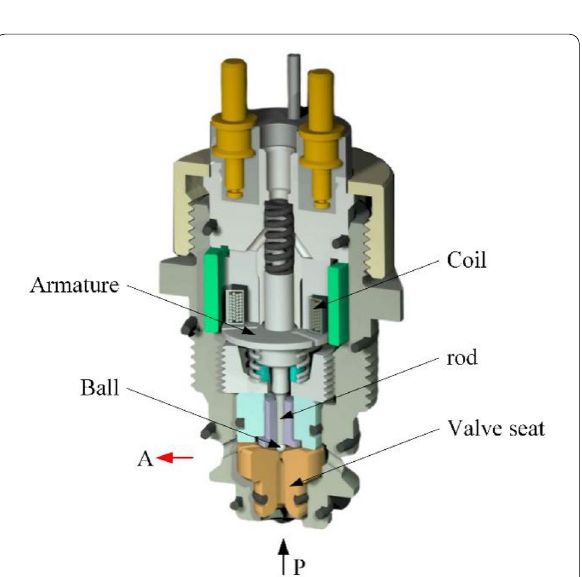
Figure 6 Ball valve with a fast actuator designed by Messner et